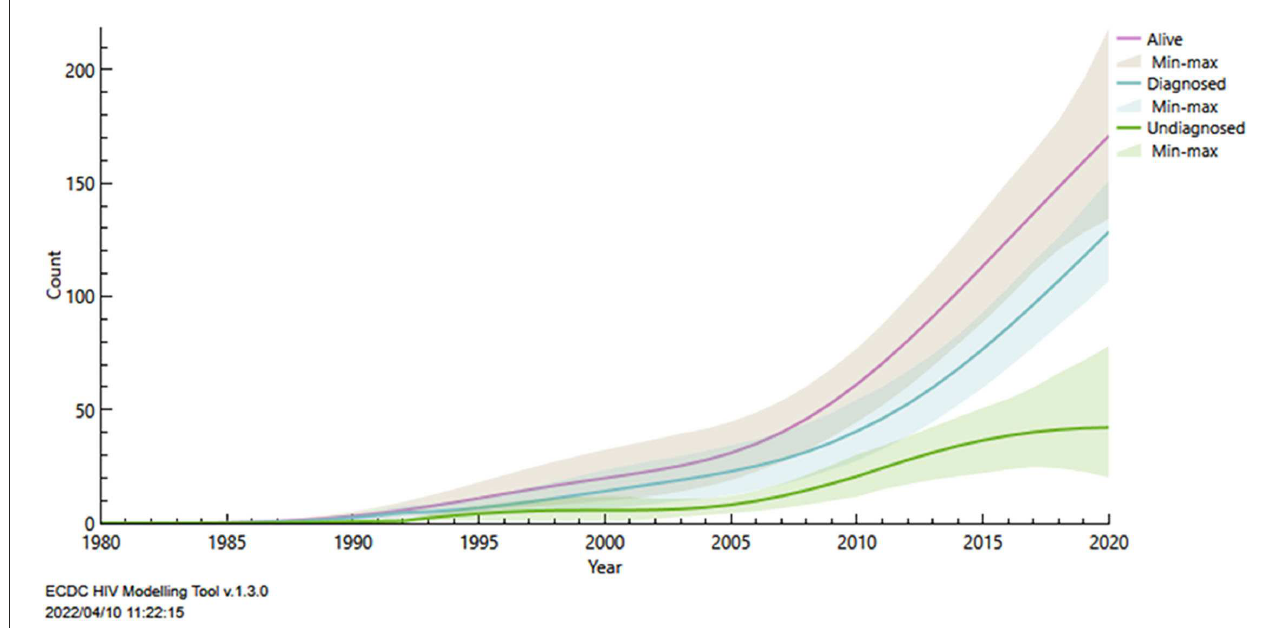
FIGURE4 Modelling of the HIV epidemic in the Saint Georges/Oiapoque basin using the ECDC modelling tool in order to estimate the total number of persons living with